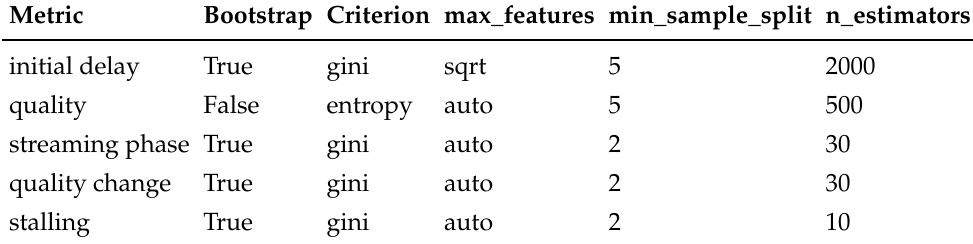
Table 9. Hyperparamters for the Random Forest based prediction.